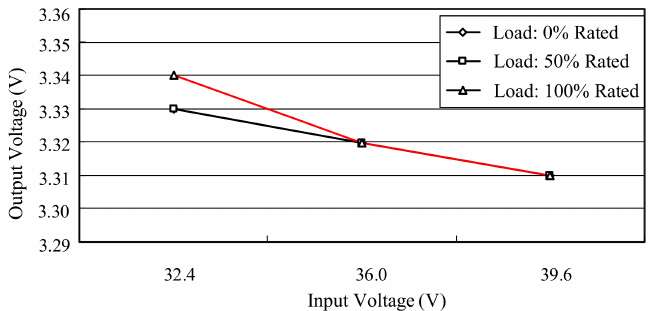
Figure 34. Curve of second secondary output voltage versus input voltage on condition that the main and first secondary outputs are located at rated